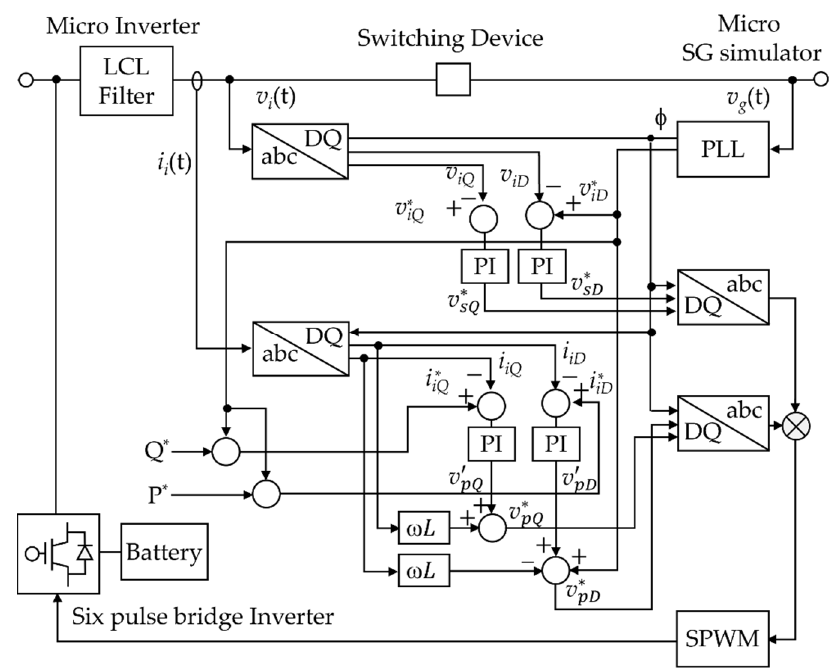
Figure 6. Grid synchronization and PQ control algorithm of micro DG